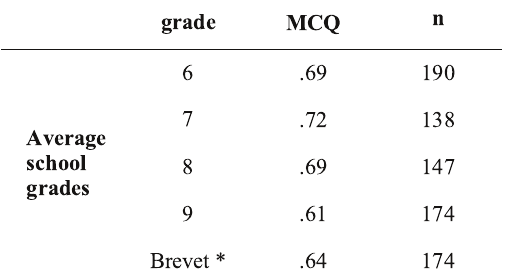
Correlations between total score (S-E or S-E/2) with encyclopedic MCQ of memory and annual school average (Lieury, 1991; Lieury et al., 1992; Lieury et al., 1995a, 1995b) in function